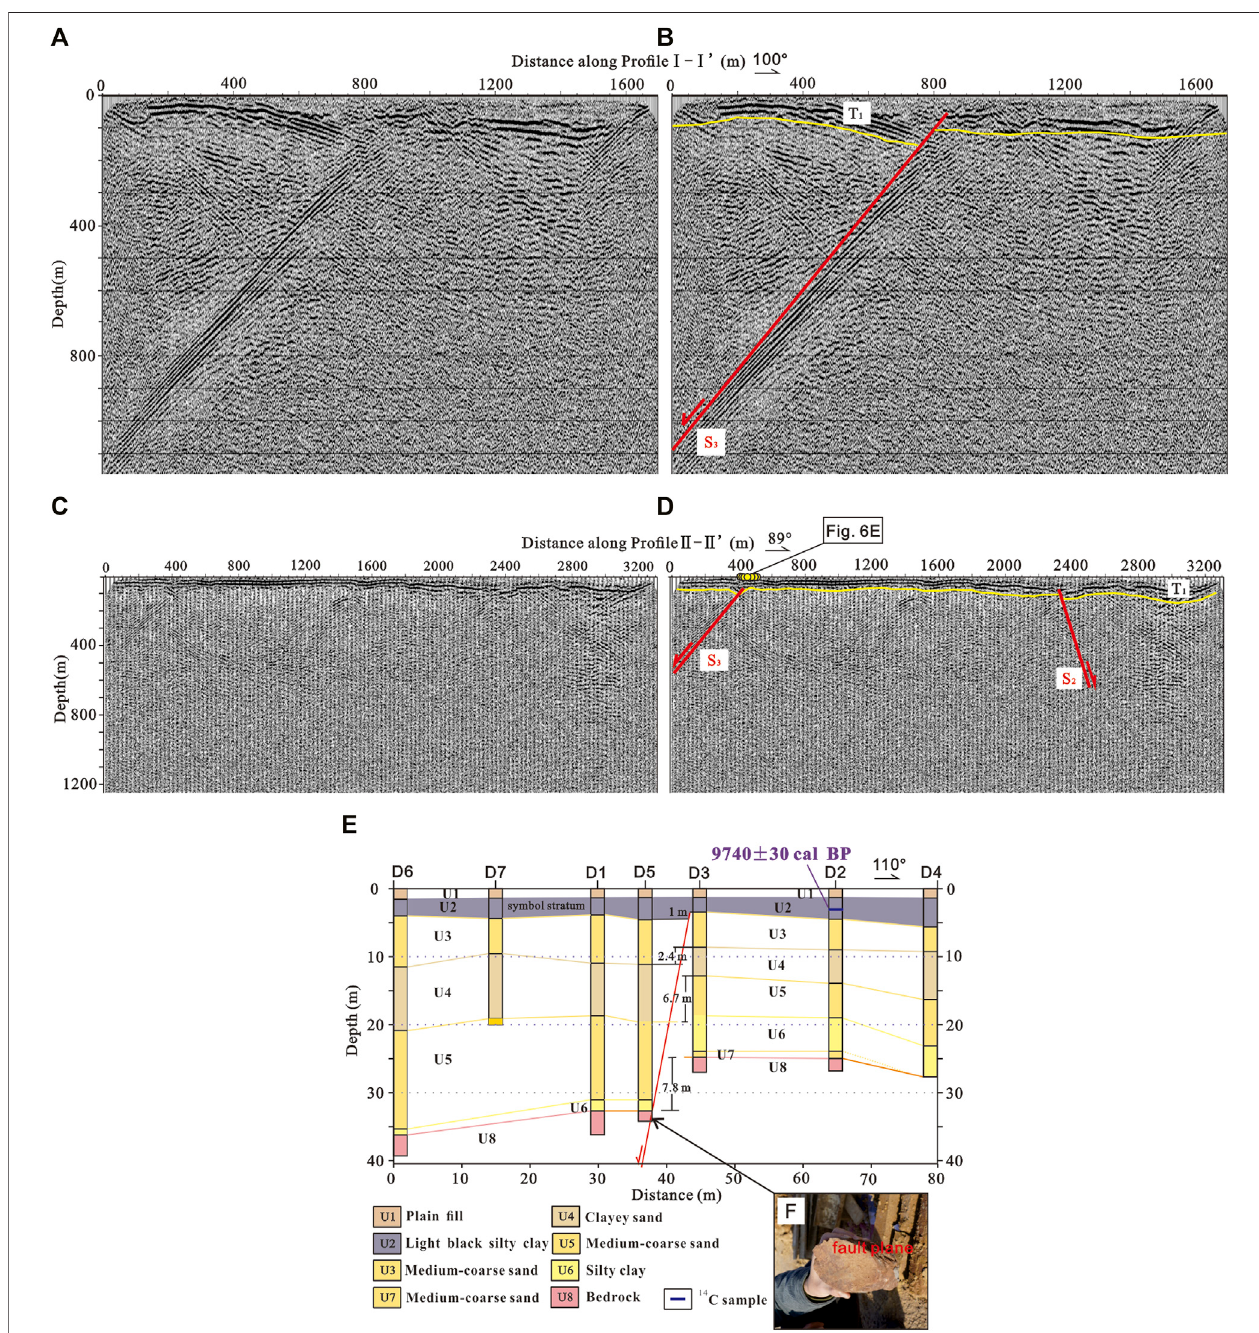
FIGURE 6 | The results from shallow seismic exploration and drilling in northern Juxian. (A,B) : section I-I ’ of shallow seismic exploration; (C,D) : Section II-II ’ of shallowseismicexplorationTheyellowcirclesin Figure6D indicatethelocationsofboreholesD1 – 7(thedetaileddistributionoftheboreholesisshownin Figure6E ). (E) : Composite drilling section to the north of Juxian; (F) : The fault plane in the broken rock obtained by drilling.